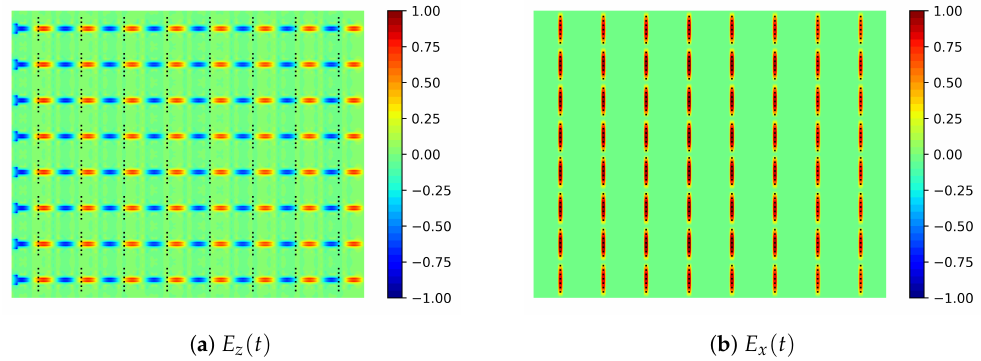
Figure 11. Simulated normalized E z ( t ) at the ridge level in the radiating section (ridges fed from the left side) and E x ( t ) at the aperture level at 31 GHz.